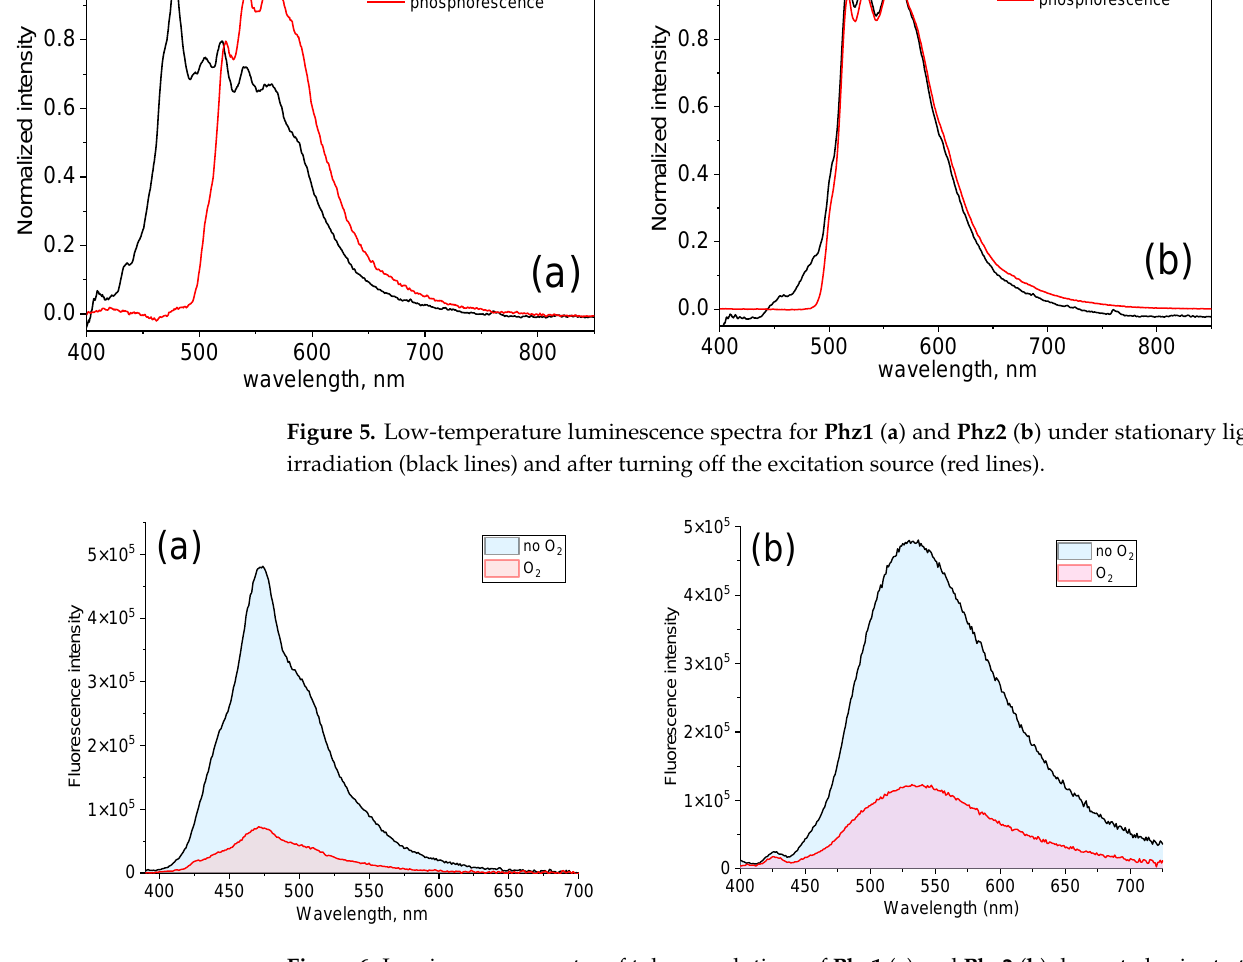
Figure 6. Luminescence spectra of toluene solutions of Phz1 ( a ) and Phz2 ( b ) deaerated prior to the measurement (black line) and bubbled with dioxygen (red line).